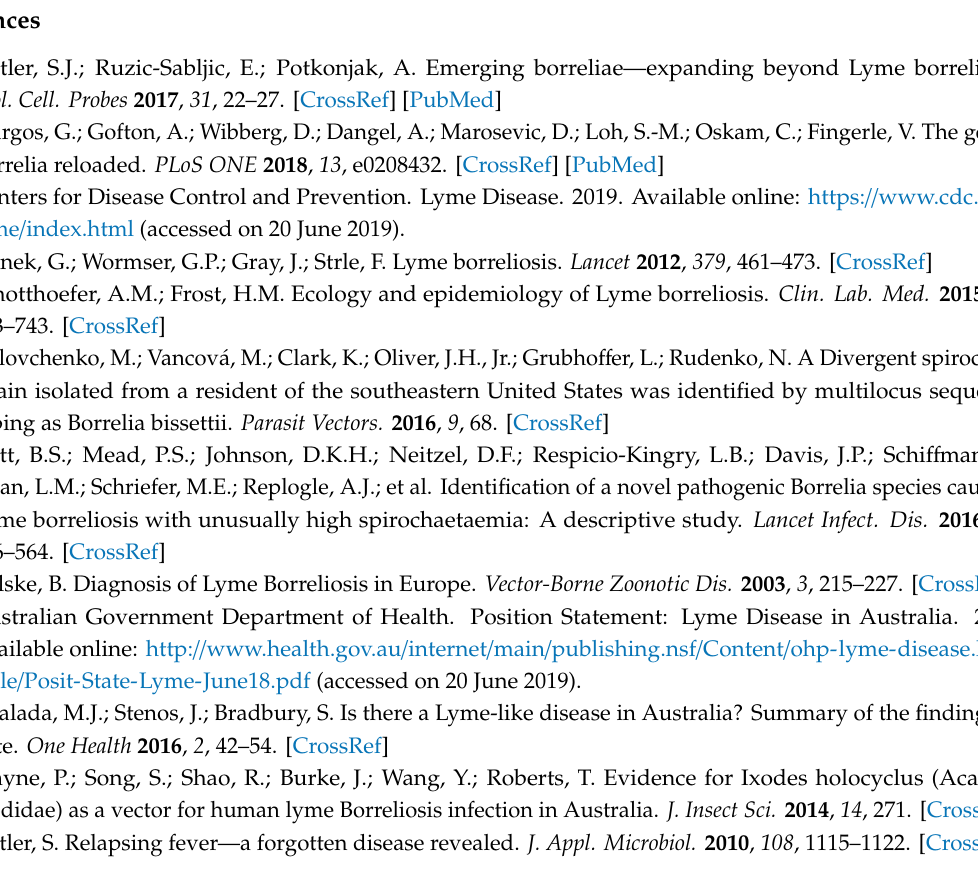
Table S1: Pertinent sequence homologies for the scoring RFB proteins in TBRF